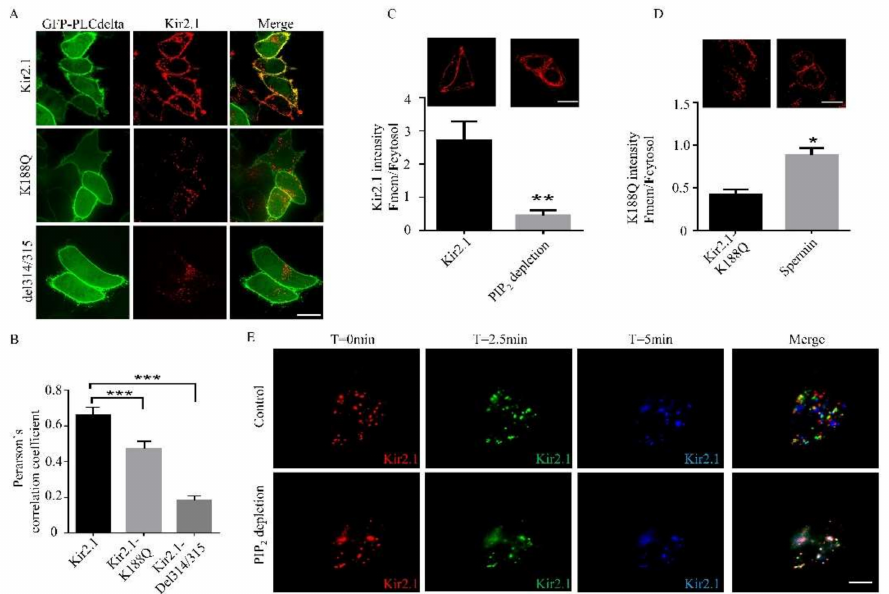
Figure 4. PIP 2 facilitates Kir2.1 cell surface expression and Kir2.1 movement at the cell membrane. ( A ) Localization and distribution of PIP 2 and Kir2.1 channels on the cell membrane. Hela cells were transfected with GFP-PLCdelta-PH and mCherry-fused Kir2.1 channels. PIP 2 was traced by PLC delta fused with GFP. Scale bar: 10 µ m. ( B ) Quantification of PIP 2 -Kir channel co-localization by Pearson’s correlation coe ffi cient. For n = 18–24 cells pooled across three independent experiments. *** p < 0.001. ( C ) Kir2.1 distribution in Hela cells before and after PIP 2 depletion. Hela cells were transfected with mCherry-fused Kir2.1. Scale bar: 25 µ m. The quantification is shown below. n = 25–33 cells pooled across three independent experiments. ** p < 0.01. ( D ) Kir2.1-K188Q fused mCherry distribution in Kir2.1-K188Q. Spermin is a Kir2.1-PIP 2 binding enhancer. Scale bar: 25 µ m. The quantification is